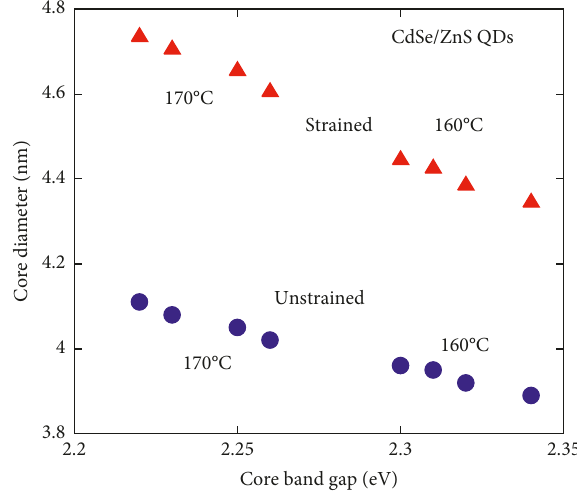
Figure 9: Core diameter of CdSe/ZnS core/shell QDs plotted and as a function of core band gap with and without strain at 160 ° C and 170 ° C,